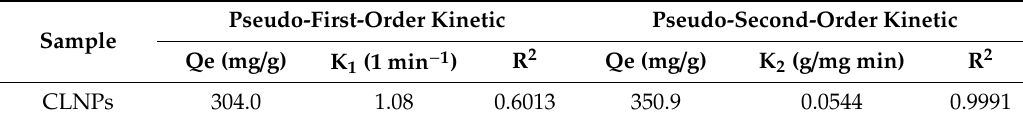
Table 3. Kinetic parameters for Pb(II) adsorption onto CLNPs.